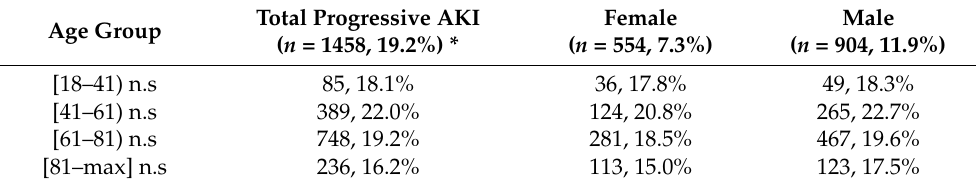
Table 4. Comparison of the proportions of progressive AKI cases within different age groups, stratified by sex. A total of 7592 AKI cases were considered for detection of progression. n —number of cases.